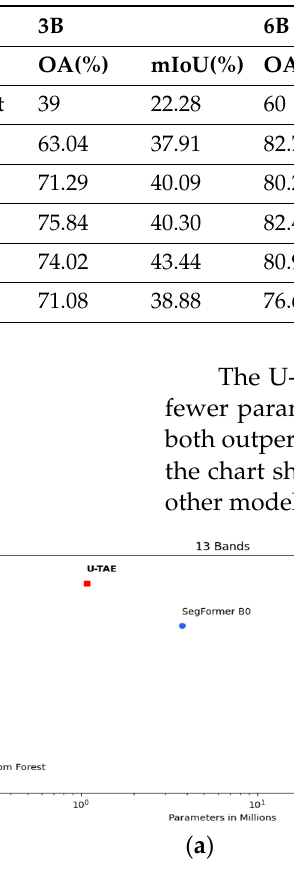
Figure 6. From left to right, top to bo tt om. Confusion matrices for the best models of ( a ) SegFormer B0, ( b ) SegFormer B5, ( c ) U-NET, and ( d ) U-TAE. The last row is the class precision, and the last column is the class recall. Percents smaller than 0.3% are omi tt ed for clarity. ( a )